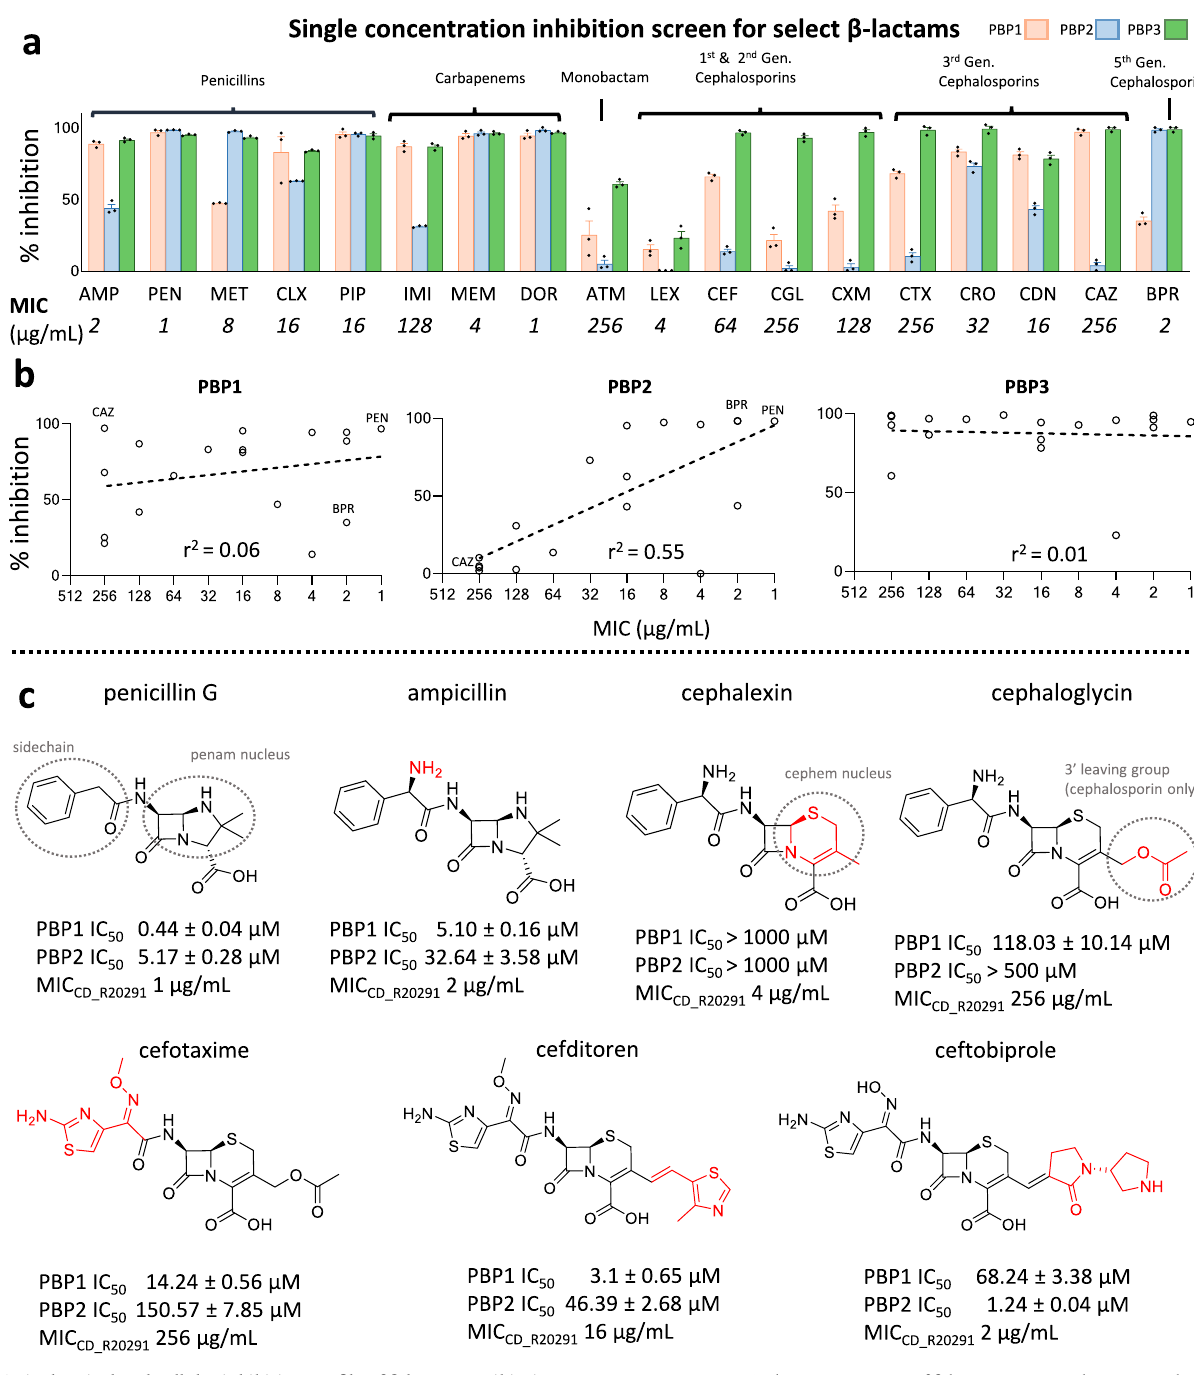
PBP2suggestsitistheprimarytargetof β -lactams. c IC 50 valuesweresubsequently determined for several β -lactams to demonstrate the chemical features that facil- itateinhibitionagainstPBP1andPBP2.Thesidechain,3 ’ leavinggroupmoieties,and thepenam,andcephemnucleiarecircledinthetoprow.Chemicalchangefromthe preceding drug (left to right) is colored in red. As shown, the cephem nucleus appearstobeassociatedwithsigni fi cantlyweakerinhibitionagainstPBP1andPBP2, but this can be overcome with chemical modi fi cations to the sidechain and 3 ’ leaving group. AMP ampicillin, PEN penicillin G, MET methicillin, CLX cloxacillin, PIP piperacillin, IMI imipenem, MEM meropenem, DOR doripenem, ATM aztreo- nam, LEX cephalexin, CEF cephalothin, CGL cephaloglycin, CXM cefuroxime, CTX cefotaxime, CRO ceftriaxone, CDN cefditoren, CAZ ceftazidime, BPR